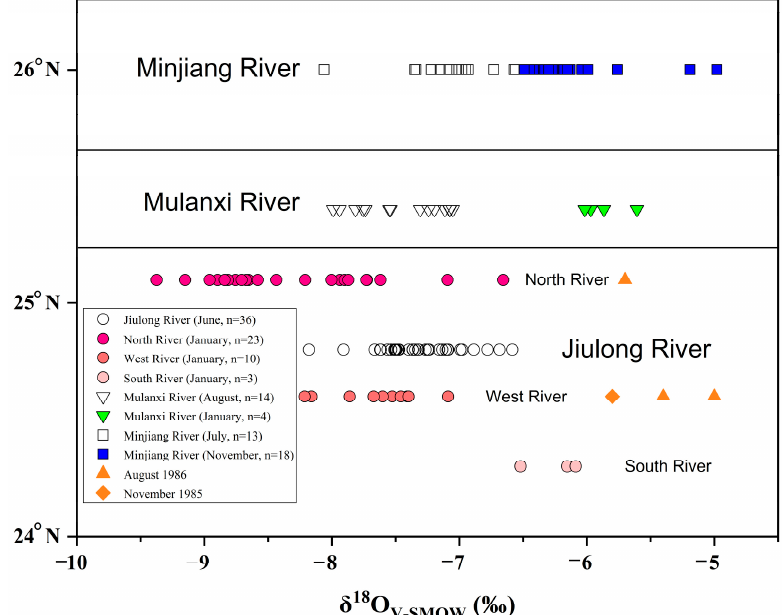
Figure 6. Fresh water oxygen isotope composition of the Jiulong River, the Mulanxi River [47], and the Minjing River [46] in southeast China.